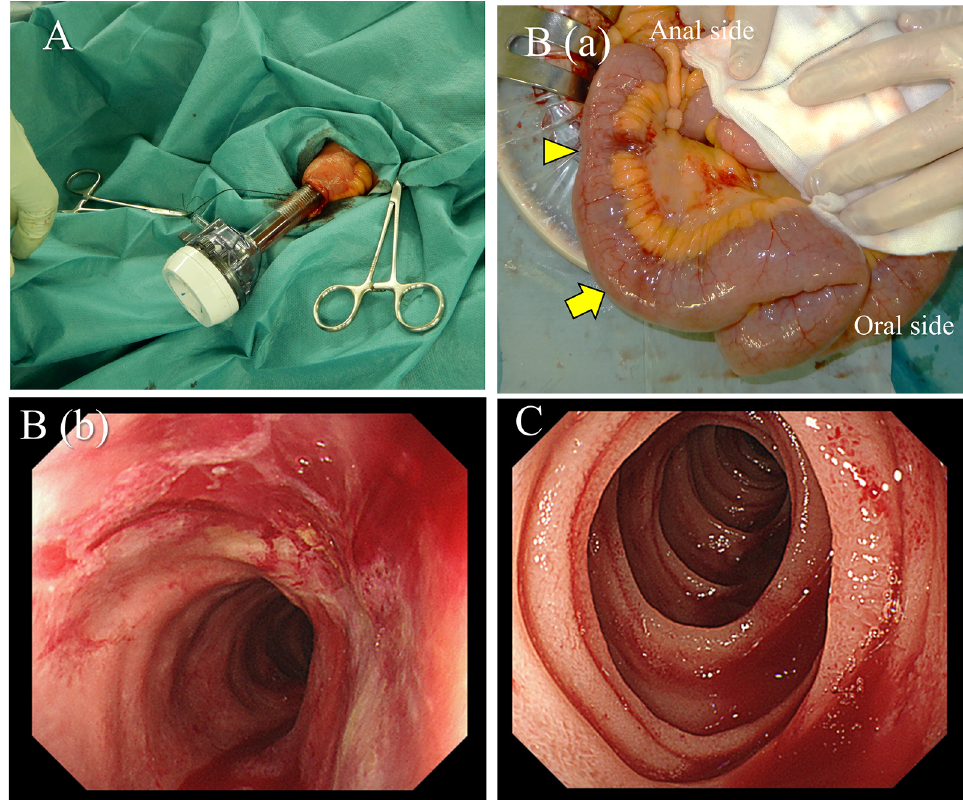
Fig. 4 A Intraoperative endoscopy was performed during the second surgery. B ( a ) Intraoperative findings showed no obvious intestinal necrosis, but the terminal ileum wall on the 25 cm oral side from the ileocecal valve was hard and thickened (arrowhead). A laparoscopic trocar was inserted 5 cm orally from there (arrow). ( b ) Intraoperative endoscopic observation on the anal side confirmed the presence of the deepest longitudinal